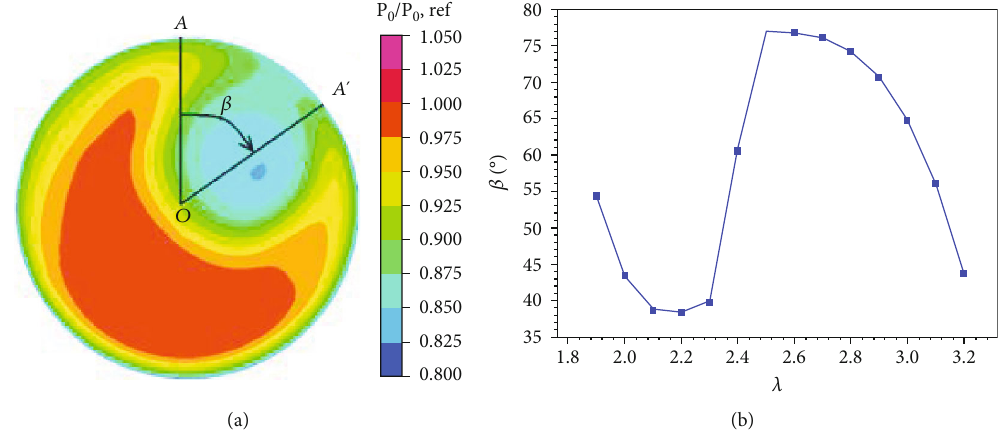
Figure 17: β varies with propeller advance ratio λ